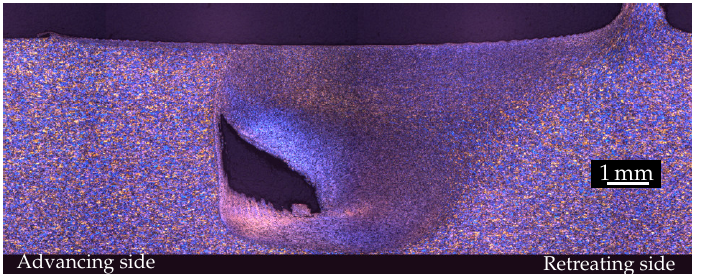
Figure 10. Barker-etched cross section of the real welding experimental corresponding to the steady state of Figure 9 with wormhole defect and burr formation on the